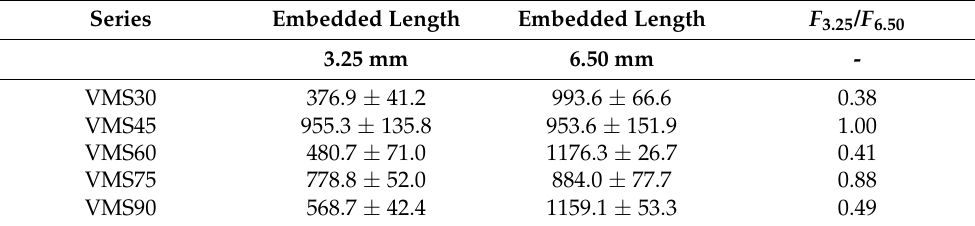
Table 2. Maximum pullout resistance stress in N/mm 2 according to Figure